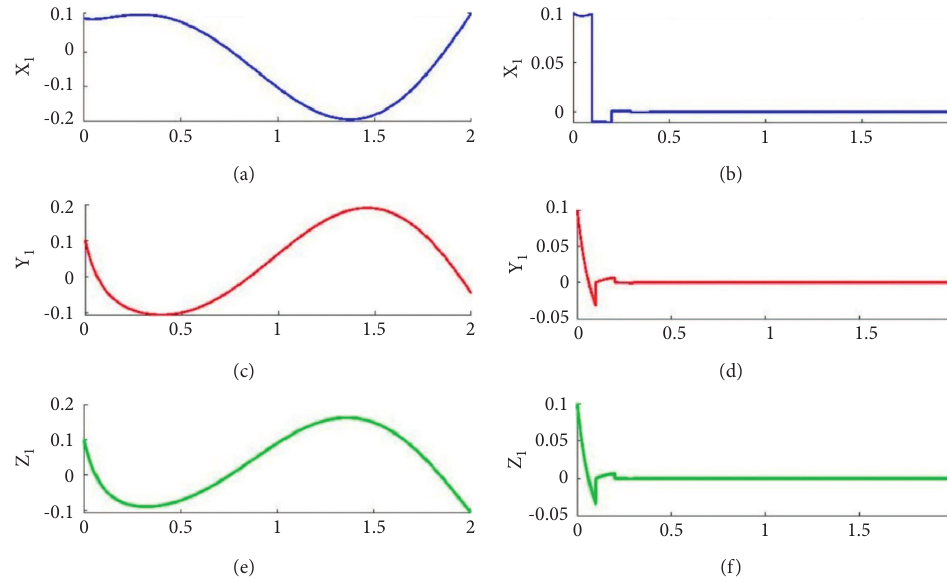
, y , and z of the system demonstrated in Equation (12) are plotted in (a), 1 1 1 , y , and z for this system under the impulsive controller (Equation (13)) are plotted in 1 1 1